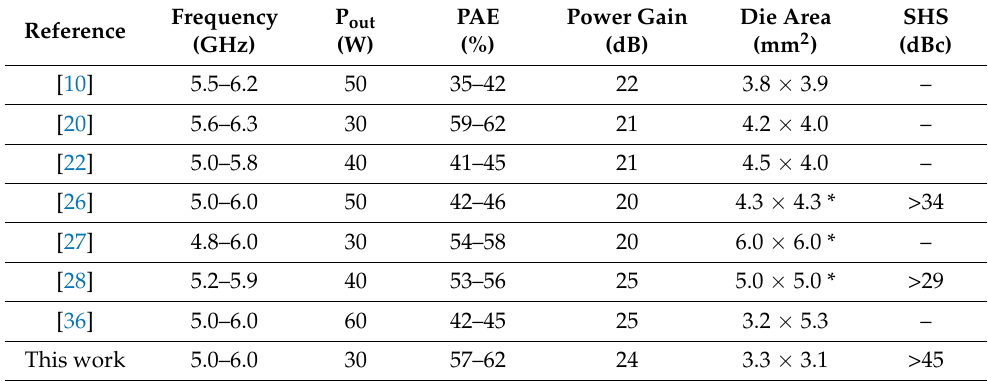
Table 1. The performance comparison with other C-band PA MMICs in previous